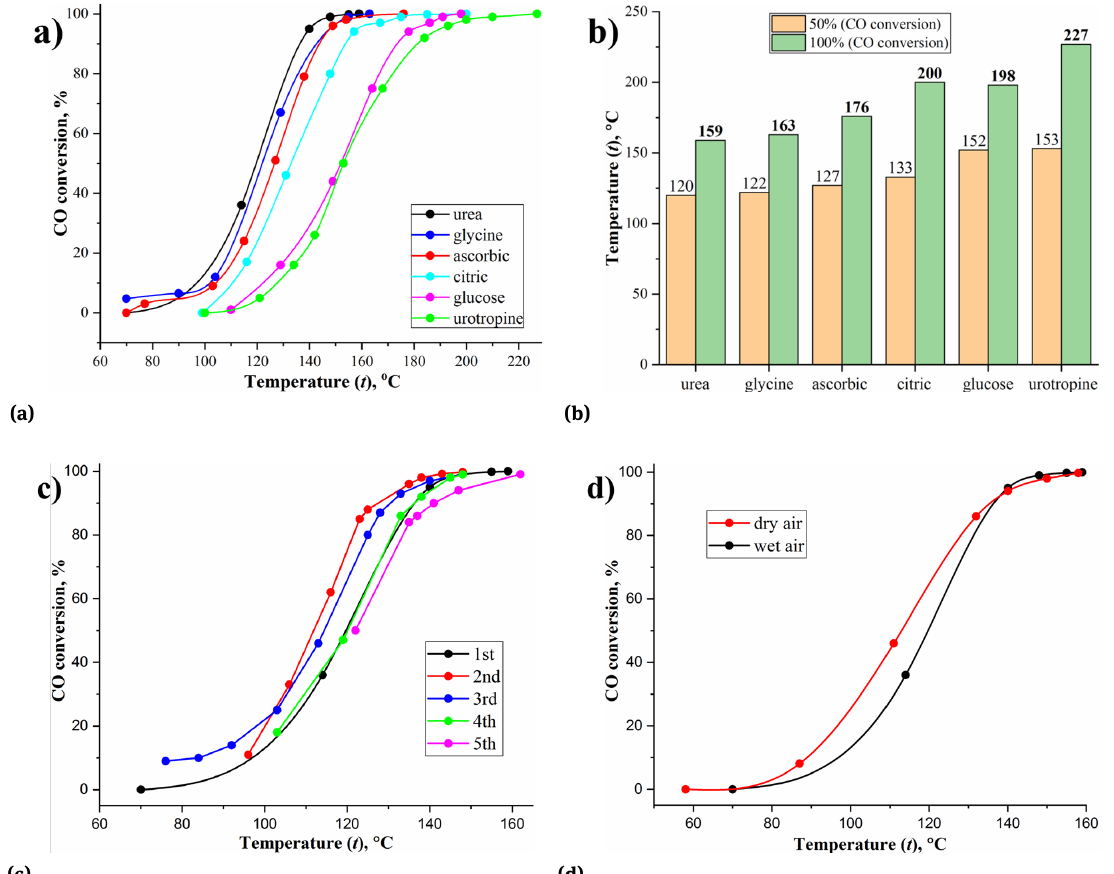
Figure 8: Results of measuring catalytic CO oxidation: a) temperature dependence of CO conversion over different catalysts; b) temperature of CO conversion at 50% and 100%; c) catalytic performance of the CuO/CeO 2 -urea catalyst reused for five times; d) effect of water vapor on CO oxidation over CuO/CeO 2 -urea